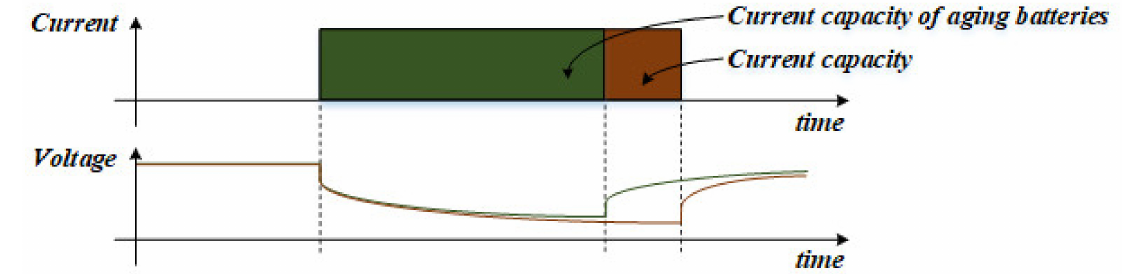
Figure 6. The current capacity of a battery during